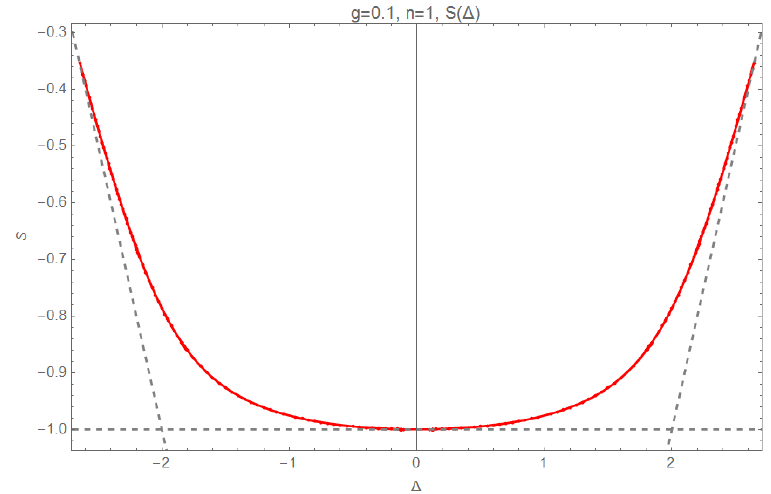
Figure 3 . Trajectory of the length-2 operator for conformal spin n = 1 and coupling constant g = 0 : 1.